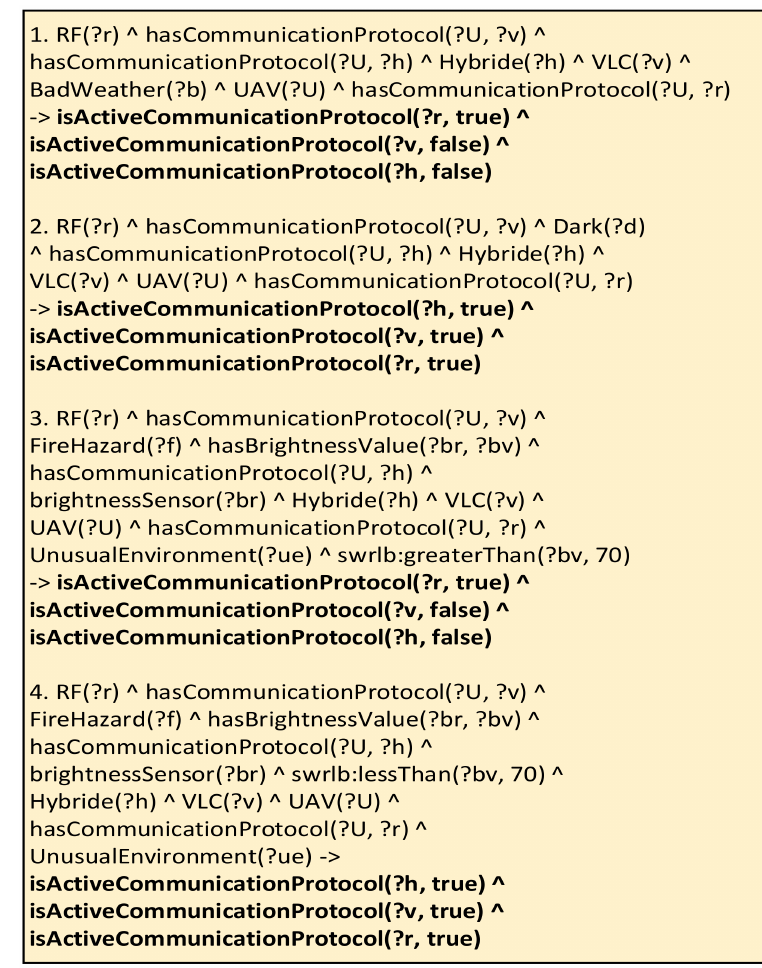
Figure 19. Rules governing activation of the communication